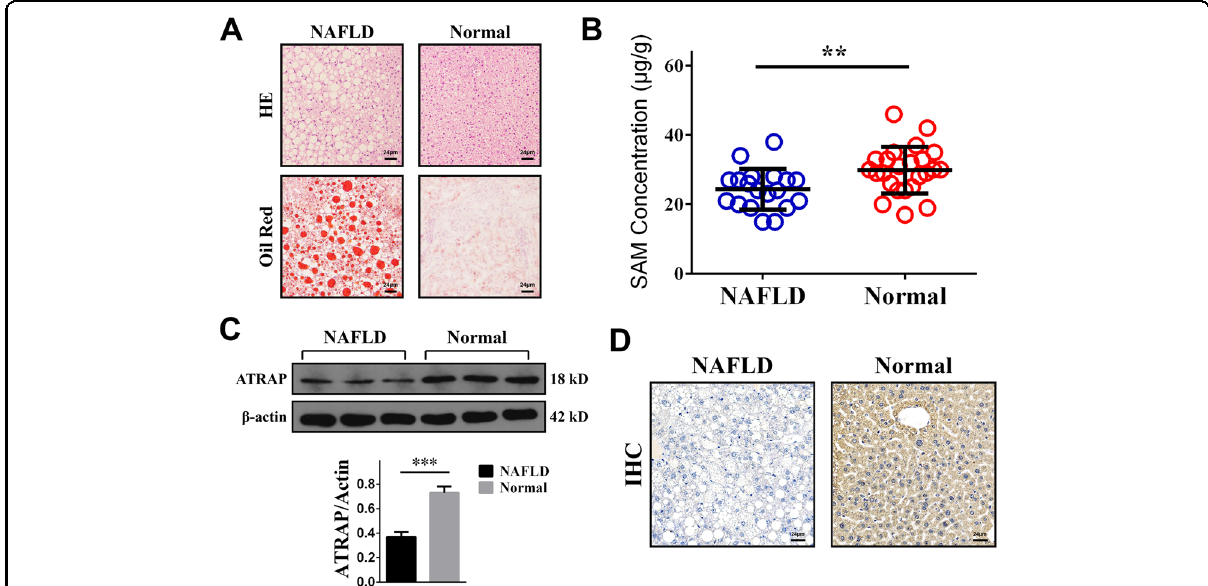
Fig. 1 SAM and ATRAP expression was downregulated in NAFLD patients. A Images of clinical NAFLD and normal liver tissues stained with HE and Oil Red O (bar = 24 μ m). B SAM concentrations in NAFLD and normal liver tissues, as determined by UPLC. C ATRAP protein levels in NAFLD and normal liver tissues, as determined by western blotting and D immunohistochemistry (bar = 24 μ m). The error bars are the SDs ( n = 3). ** P < 0.01, *** P <